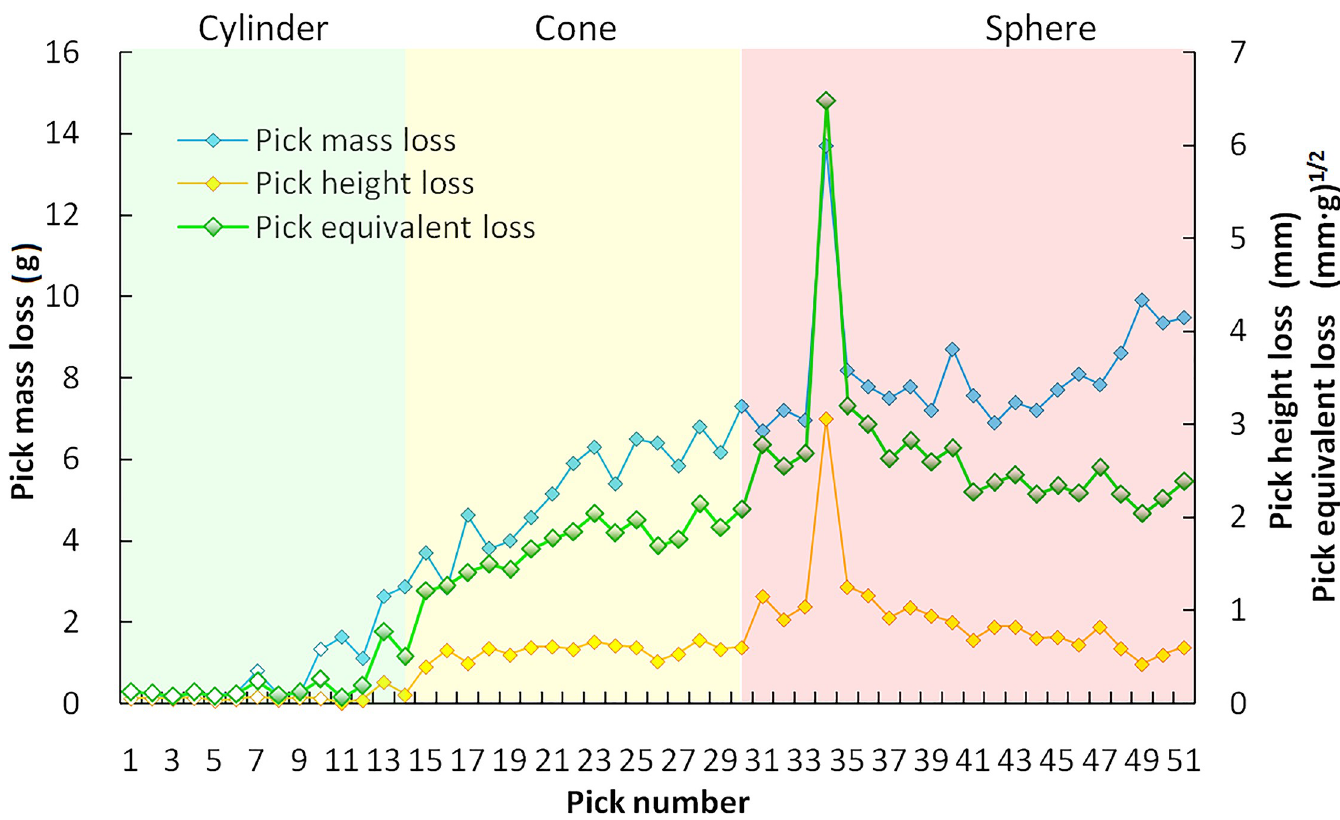
Fig 26. Pick consumption of CH51 cutting